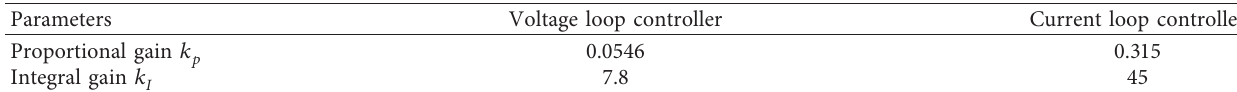
Figure 4: Block diagram of the modified droop method with both converters and their control loops. Table 2: Parameters of the PI controller for the outer and inner loop controllers.